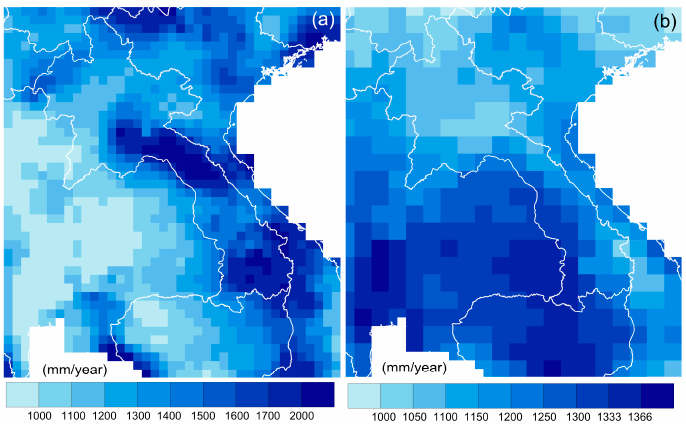
Figure 5. Spatial variability of mean climate variables across the Lower Mekong Basin. ( a ) Median annual rainfall derived from Aphrodite [36]. ( b ) Standard evapotranspiration derived from CRU [38].